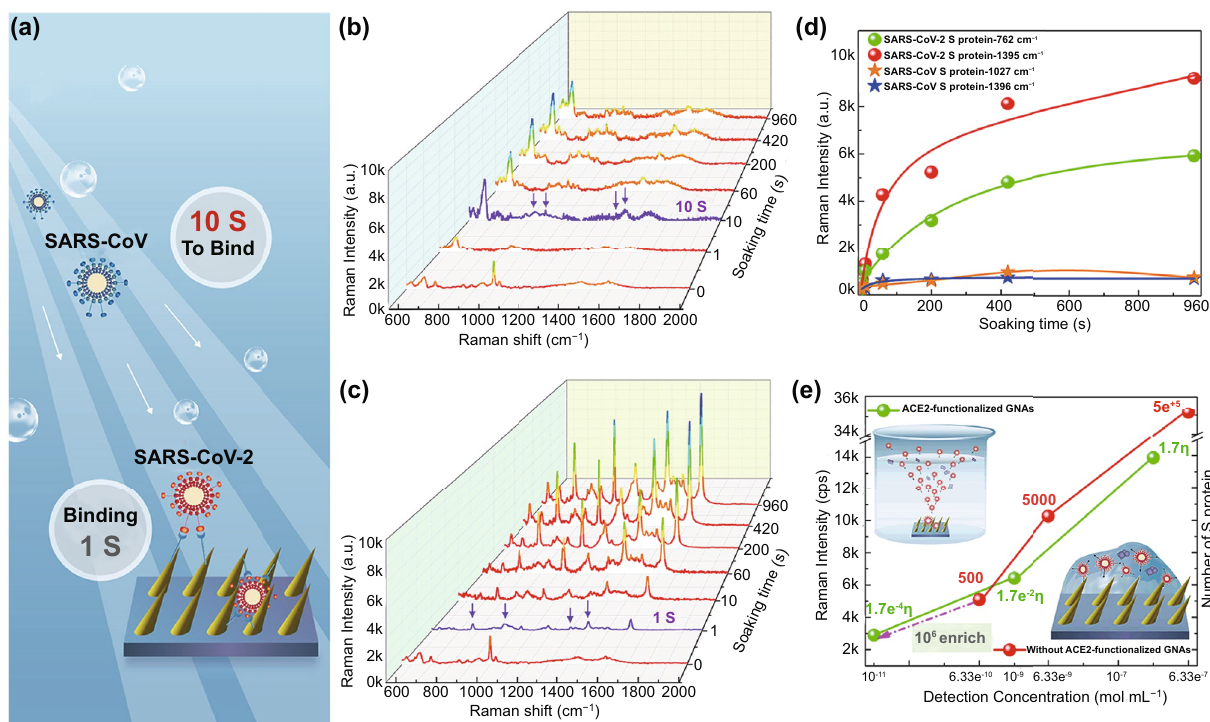
Fig. 3 Affinity analysis of SARS‑CoV‑2 S, SARS‑CoV S with ACE2. a Schematic illustration of S proteins’ binding on ACE2‑functionalized GNAs of SARS‑CoV‑2 and SARS‑CoV. SERS spectra of b SARS‑CoV and c SARS‑CoV‑2 S proteins at the same concentration of 177 nM after bound to ACE2‑functionalized GNAS for different binding time durations. d Intensity of detected SERS signals of SARS‑CoV‑2 S and SARS‑CoV S after bound to ACE2‑functionalized GNAs with different binding times. e Intensity of Raman bands (1027 cm −1 ) of SARS‑CoV‑2 S with different concentration detected with ACE2‑functionalized GNAs by immersing in the diluted protein solution, and without ACE2‑func‑ tionalized GNAs by dropping the corresponding concentration of diluted protein solution. It is worth noting that the application of dropping method is because GNAs without ACE2 modification have little affinity with SARS‑CoV‑2 S protein. The value marked on the line represents the number of S proteins in one Raman‑focused window. η represents enrichment multiple by